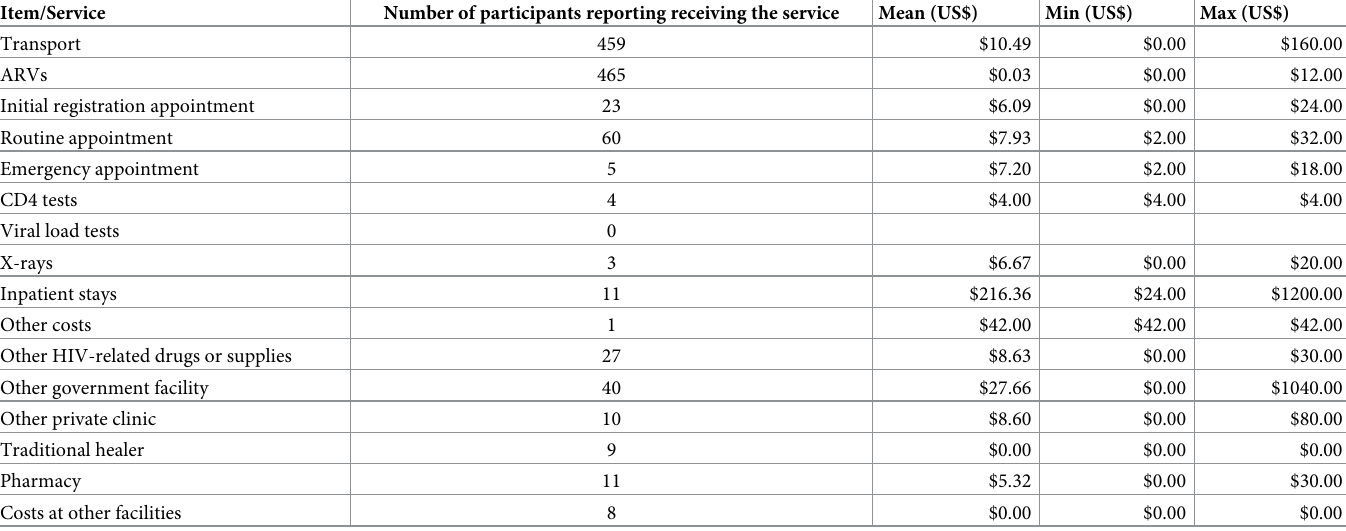
Table 3. Estimated participant annual costs for receiving PMTCT services among participants who incurred costs associated with that service or consumable, Zim- babwe 2017 � .